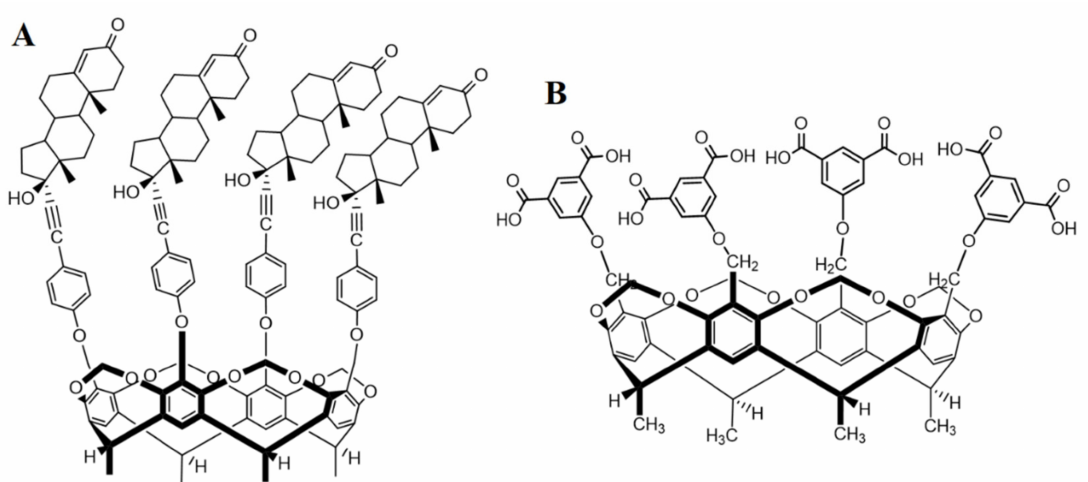
Figure 2. Chemical structures of the macrocyclic host molecules TAC ( A ) and TDC ( B ) (8-H, 9-H and 13-H of the steroidal skeleton are omitted for